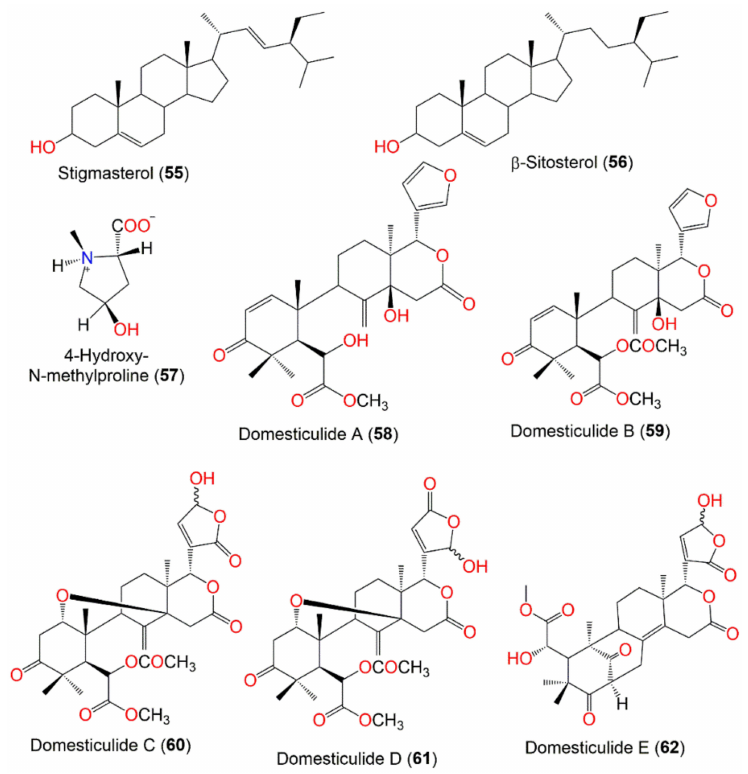
Figure 5. Structures of compounds 55 – 62 from Lansium domesticum